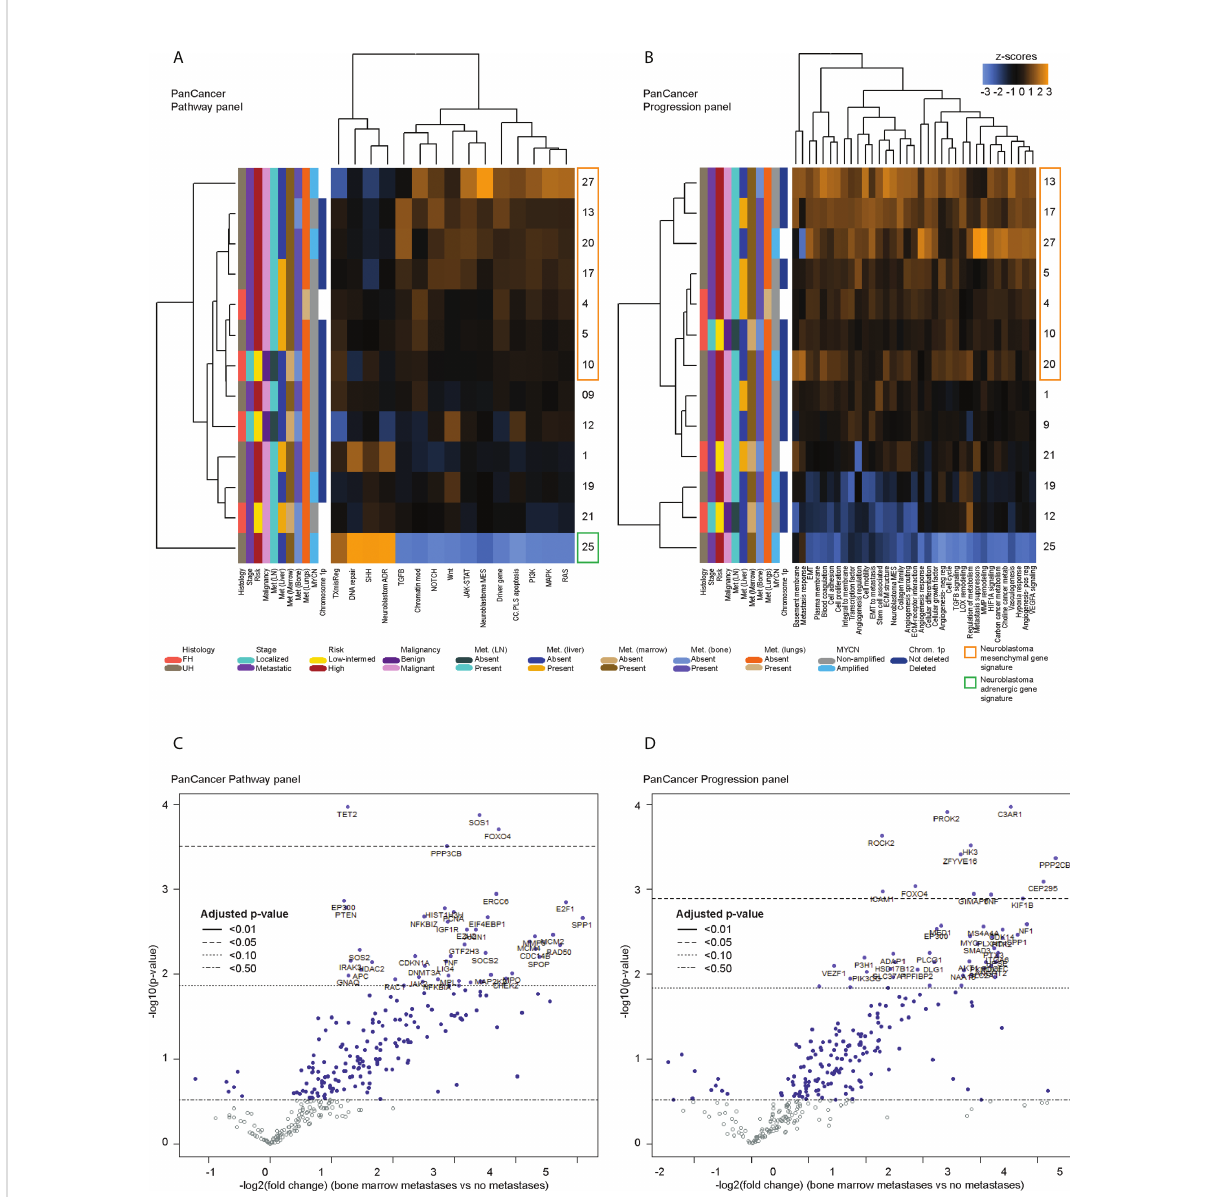
FIGURE 2 Differentially expressed genes in CTCs of neuroblastoma patients with bone marrow metastases. Heatmaps of unsupervised non-hierarchical clustering of the pathway signature scores of gene sets from (A) the PanCancer Pathway Panel, representing 13 cancer-associated canonical pathways, and (B) the PanCancer Progression Panel representing pathways involved in the cancer progression process, in CTC fractions of 13 neuroblastoma patients at initial diagnosis. Volcano plots of genes from the (C) PanCancer Pathway Panel, and (D) PanCancer Progression Panel that were signi fi cantly more upregulated in patients with bone marrow metastases than those without metastases, with multiple measures correction using the Benjamini-Hochberg method. Dot colors and reference lines indicate corresponding adjusted p-value